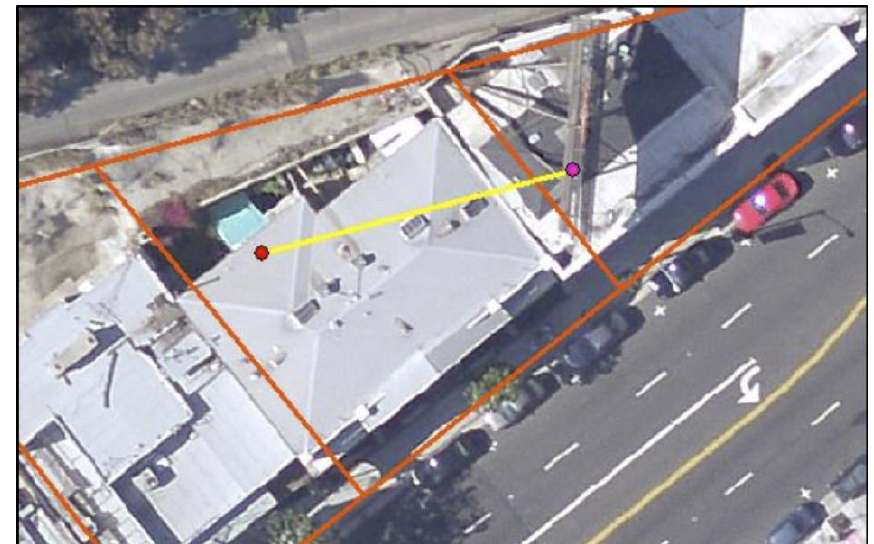
Figure 5. Sample image from ArcMap with web point separated from corresponding field point by one